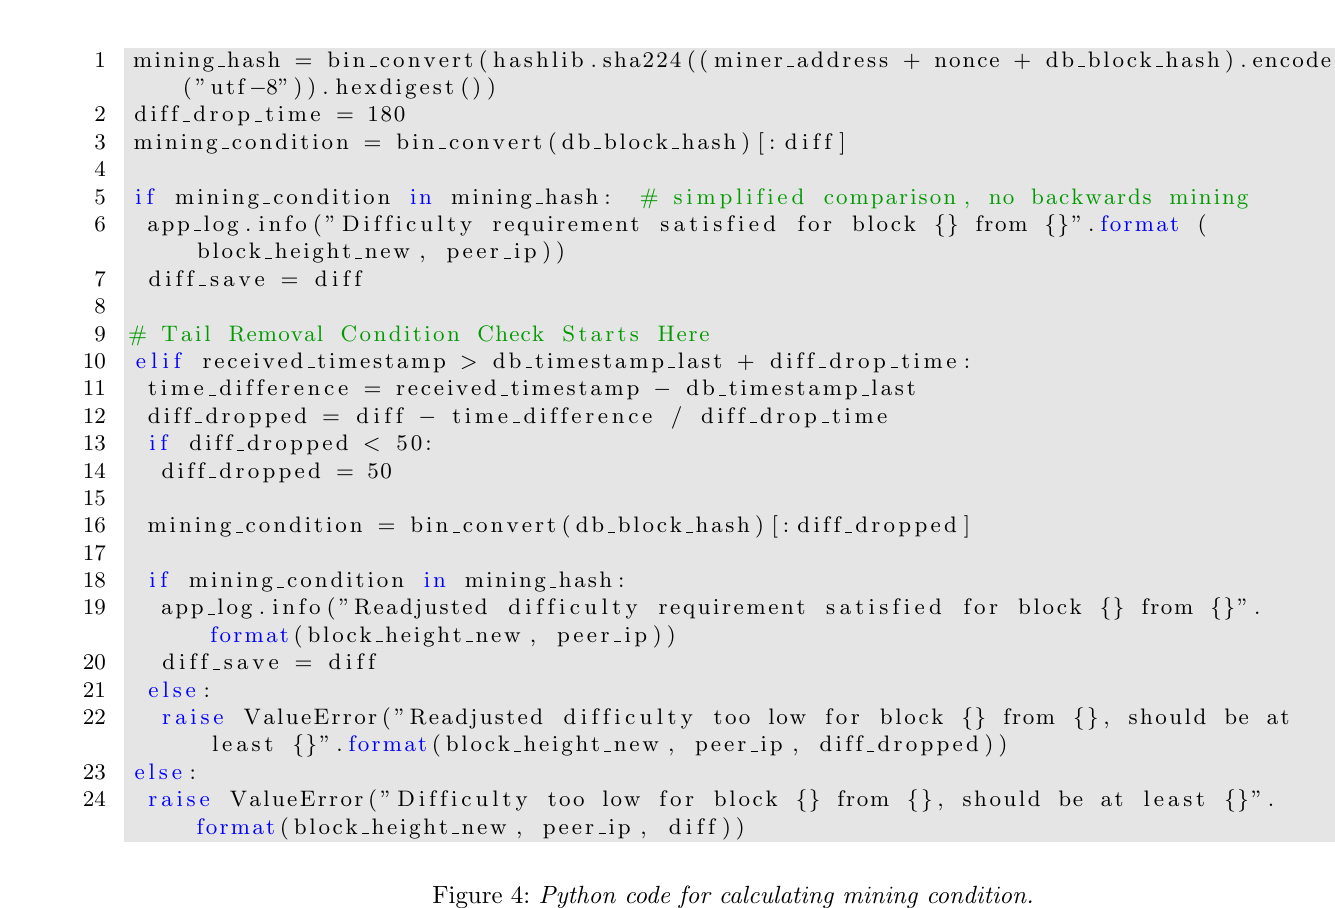
Figure 4: Python code for calculating mining